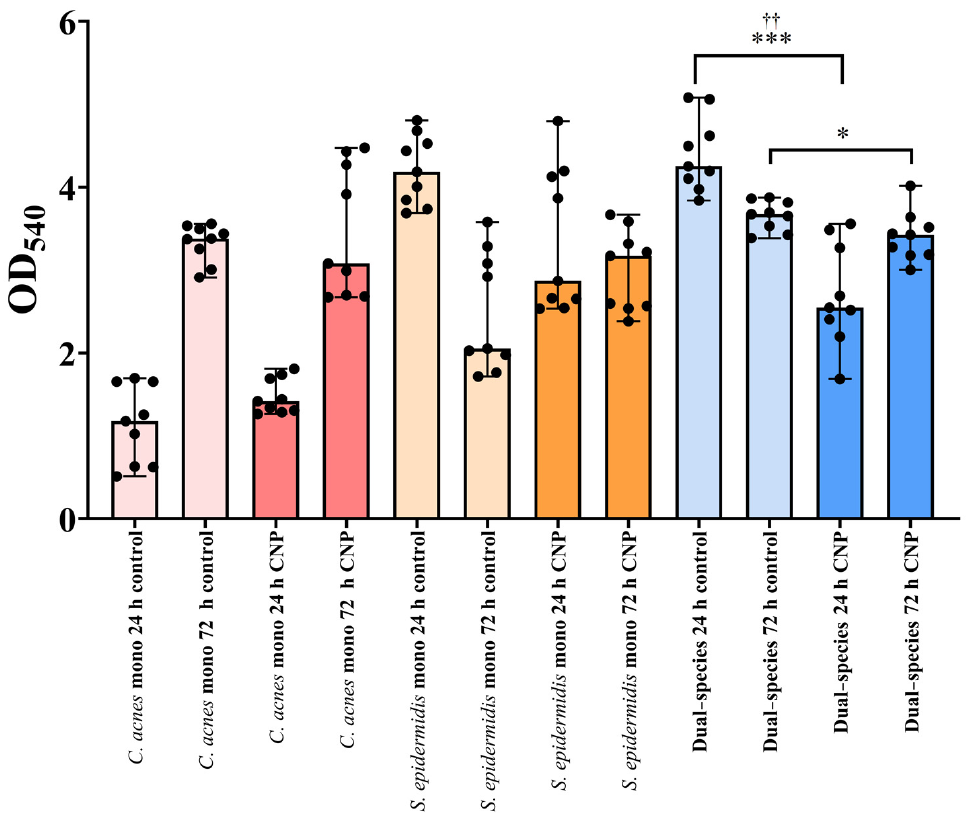
Figure 3. MTT staining of mono-species and dual-species biofilms of C. acnes and S. epidermidis on GMFFs. Symbols: * represents p < 0.05; *** represents p < 0.001; †† represents q < 0.005; absence of daggers represents q ˃ 0.05.